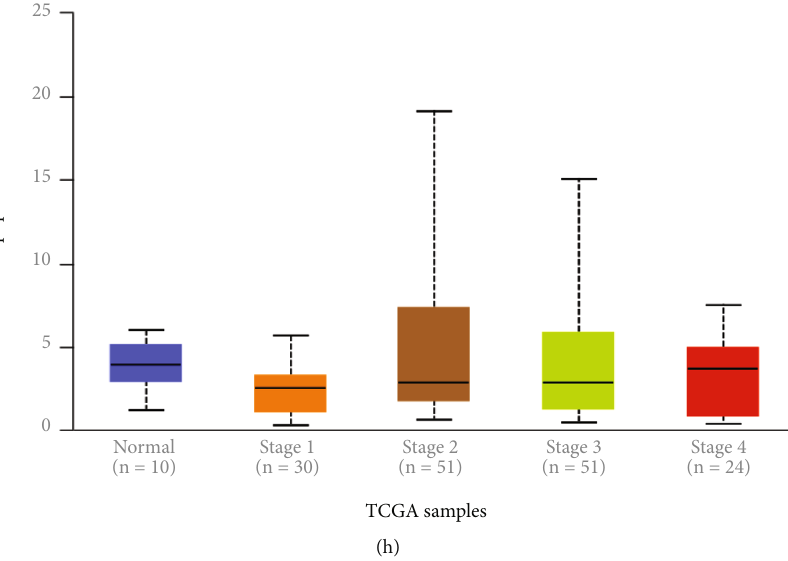
Figure 5: Correlation between IL1RN and PRRX1 mRNA expression level and clinicopathological parameters of CRC through the UALCAN database. (a) – (d) Sample type (normal/primary tumor). (e) – (h) Cancer stage (stages 1, 2, 3, and